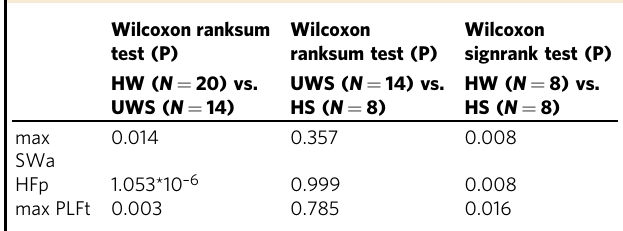
Table 1 Statistical analyses performed between groups stimulated over